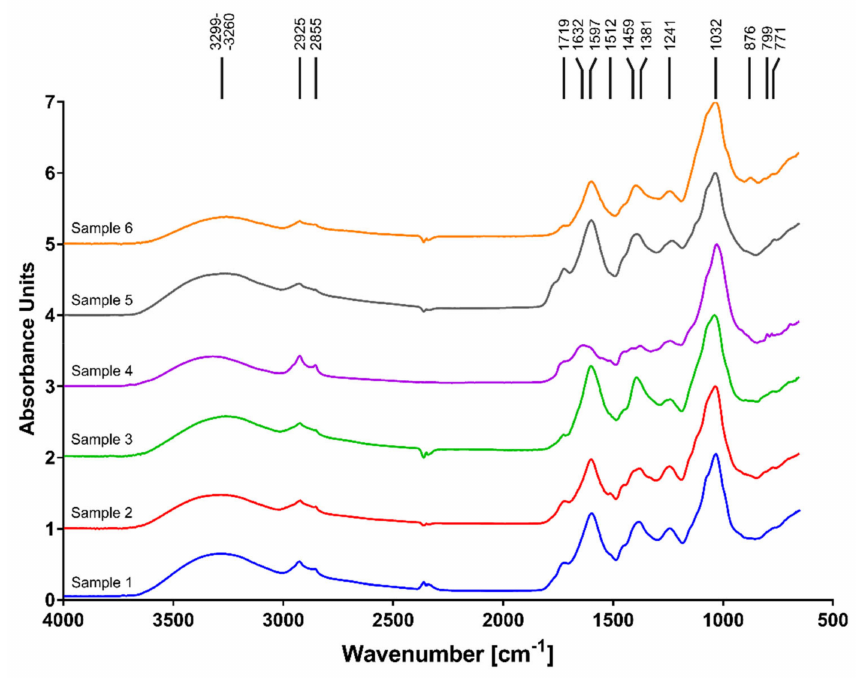
Figure 3. FTIR-ATR spectra of the aqueous ant nest extracts E1–E6 (samples 1–6,